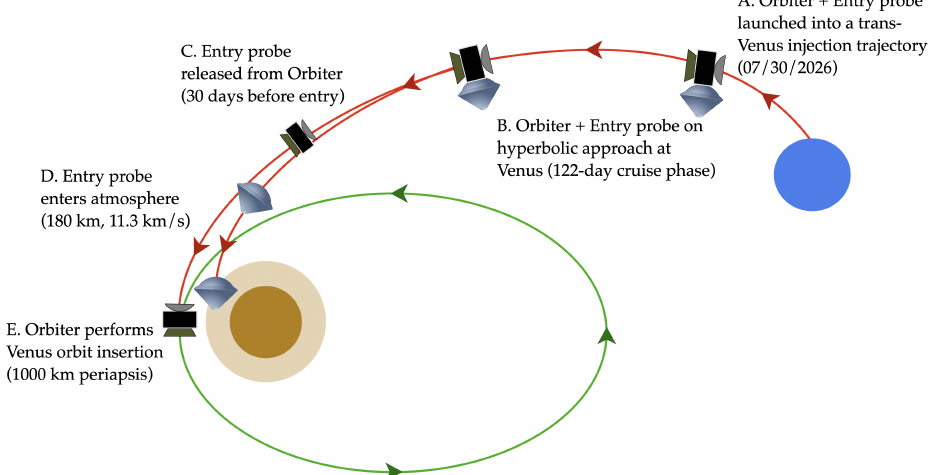
Figure 2. Baseline mission architecture for a 2026